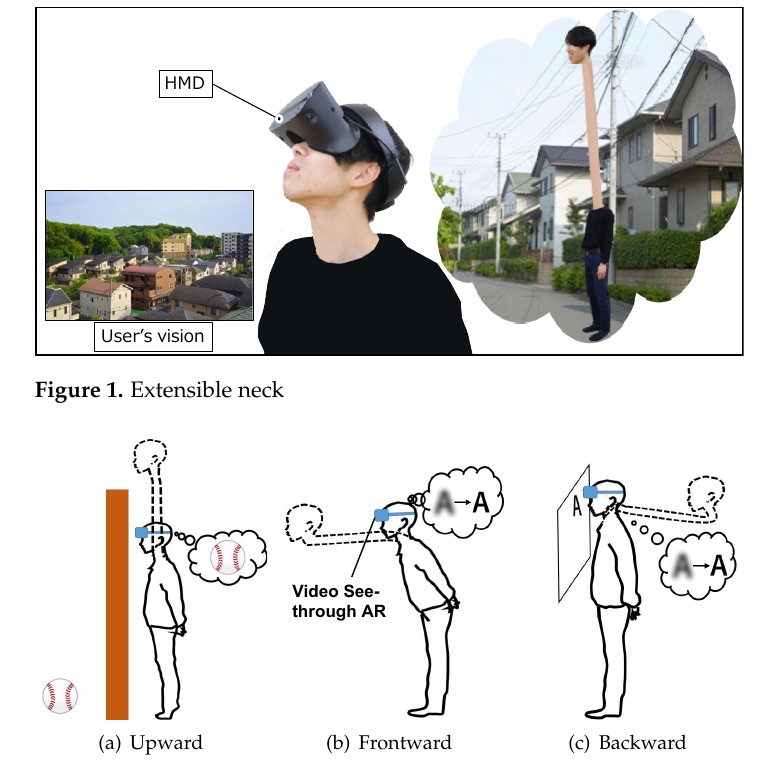
Figure 2. The situations using proposed